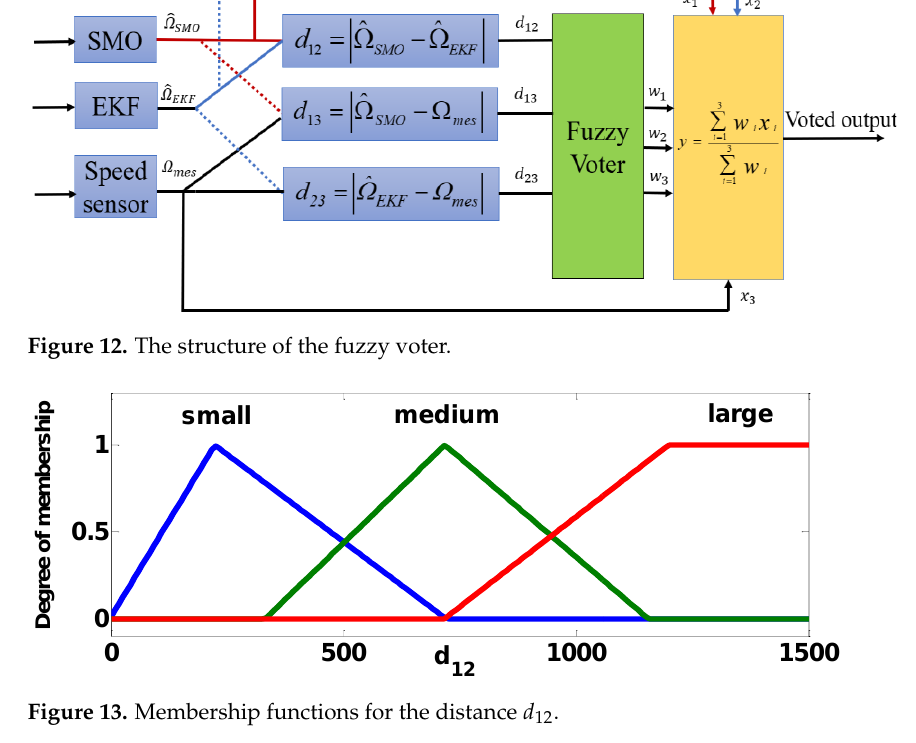
Figure 13. Membership functions for the distance 𝑑 12 .